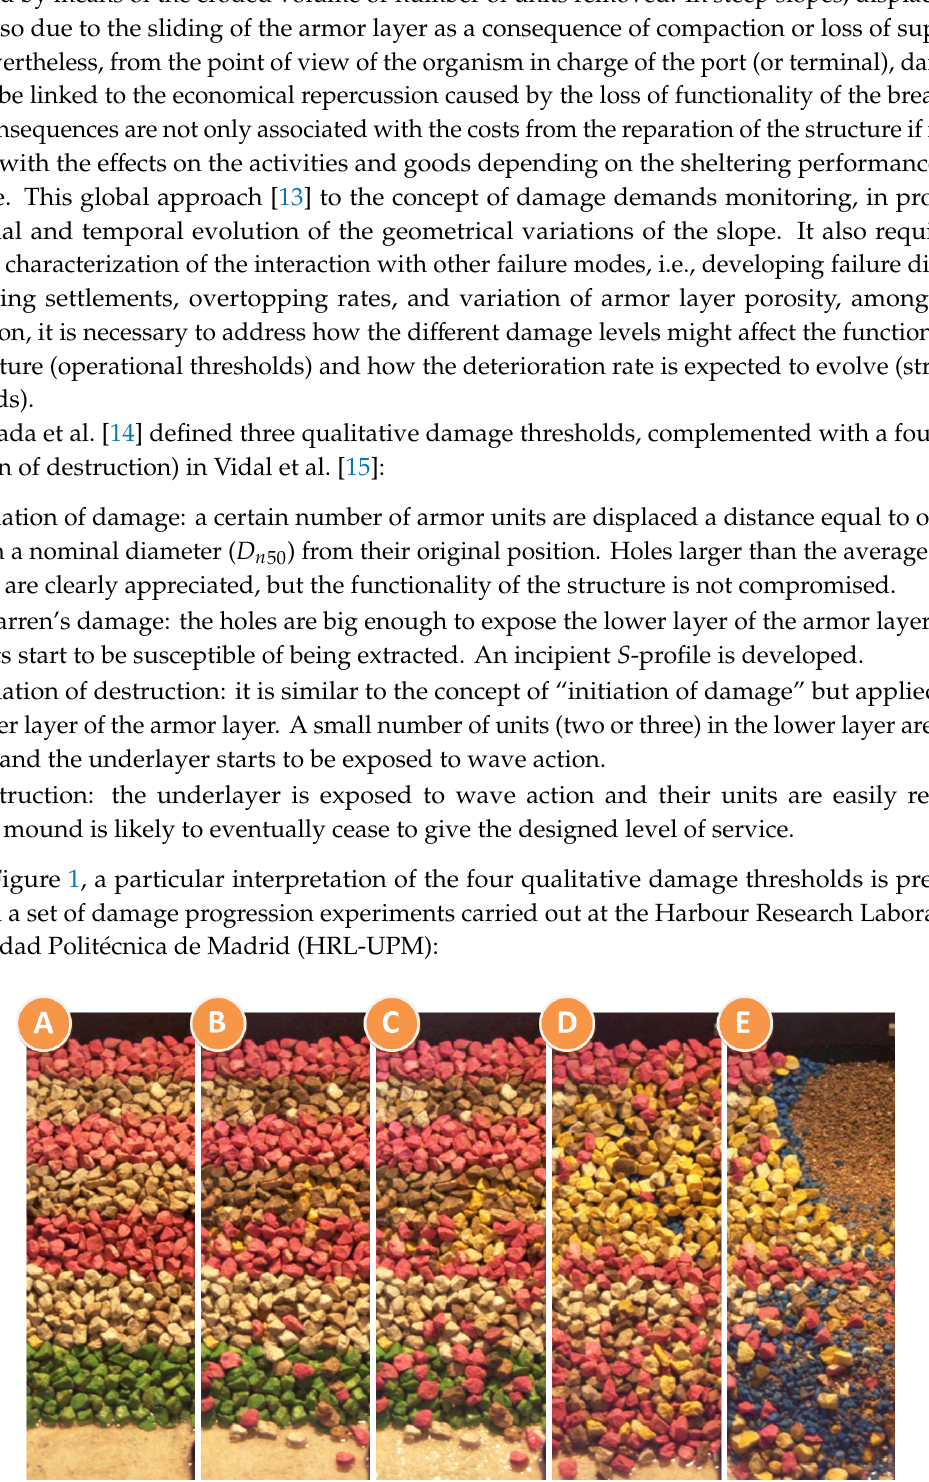
Figure 1. Particular interpretation of the qualitative damage criteria defined in Vidal et al. [15] after a set of damage progression experiments carried out at the HRL-UPM of Madrid, Spain: ( A ) non-damaged section, ( B ) initiation of damage, ( C ) Iribarren’s damage, ( D ) initiation of destruction, ( E )